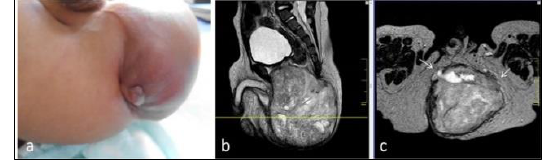
Figure 7: Seven-month-old boy presenting with a gluteal swell- ing (a). Mid sagittal MRI (b) showing the deep extension of a predominantly solid mass, and the axial section (c) showing lo- cal tumor invasion by breeching the capsule (white arrows).